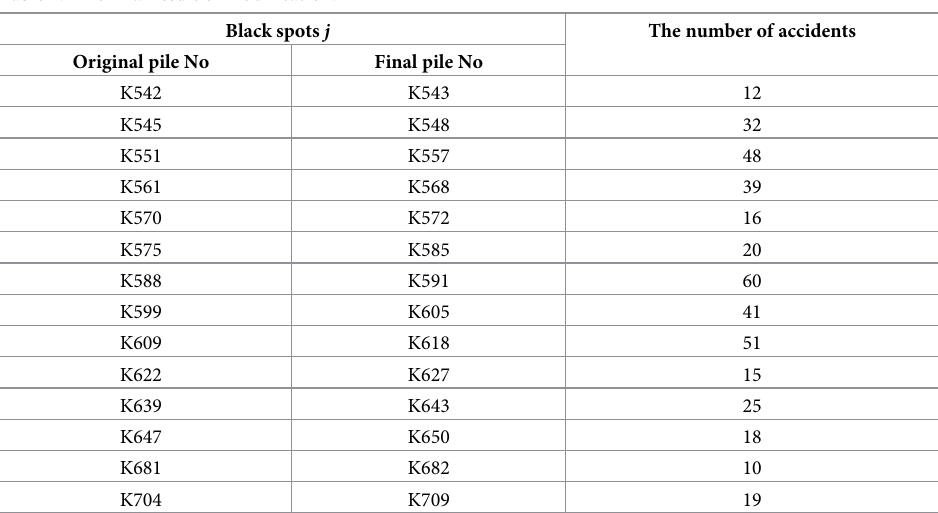
Table 4. The final result of modification.